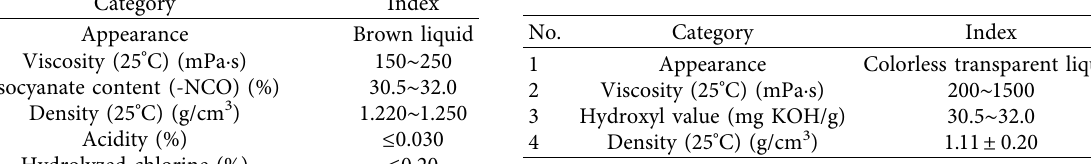
Figure 3: Material composition of polyether combinations. Table 3: Physical and chemical properties of polyether